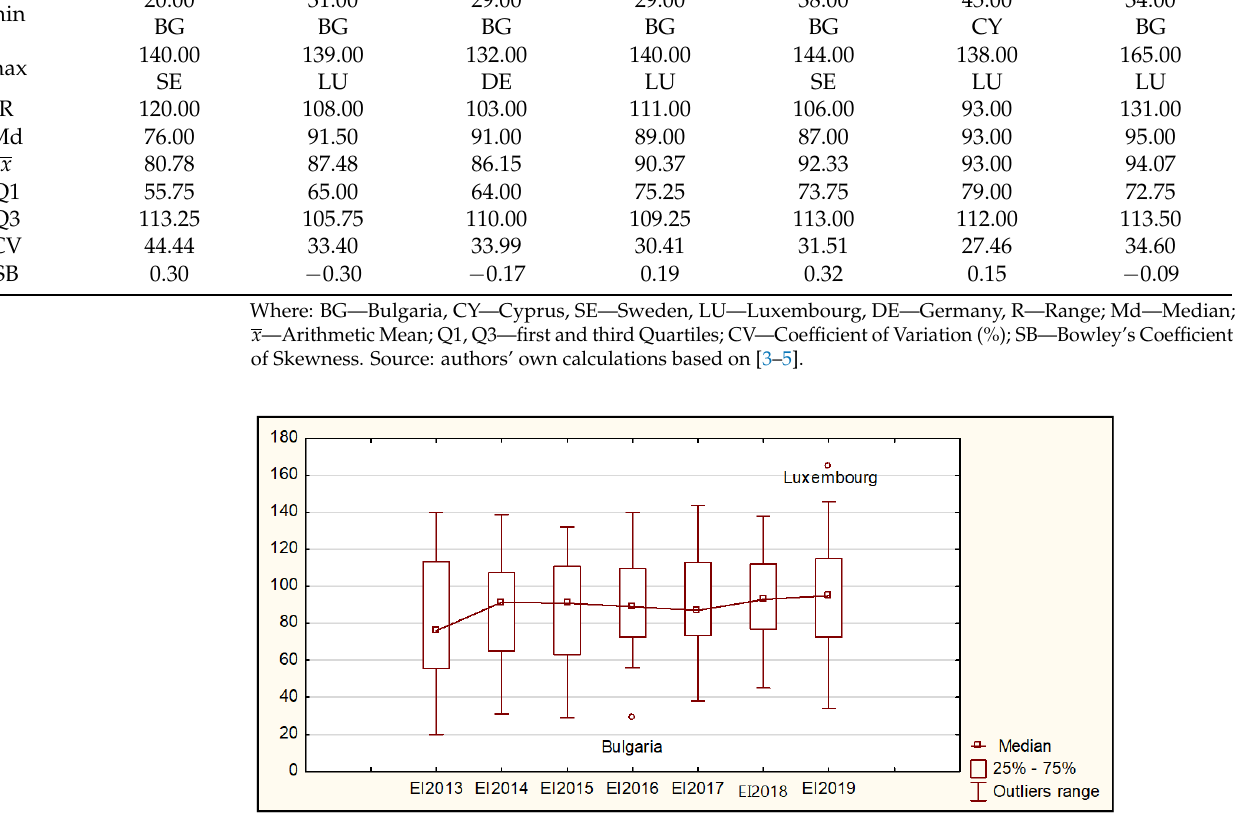
Figure 1. Box plot of the Eco-Innovation Index for the EU countries in the years 2013–2019.